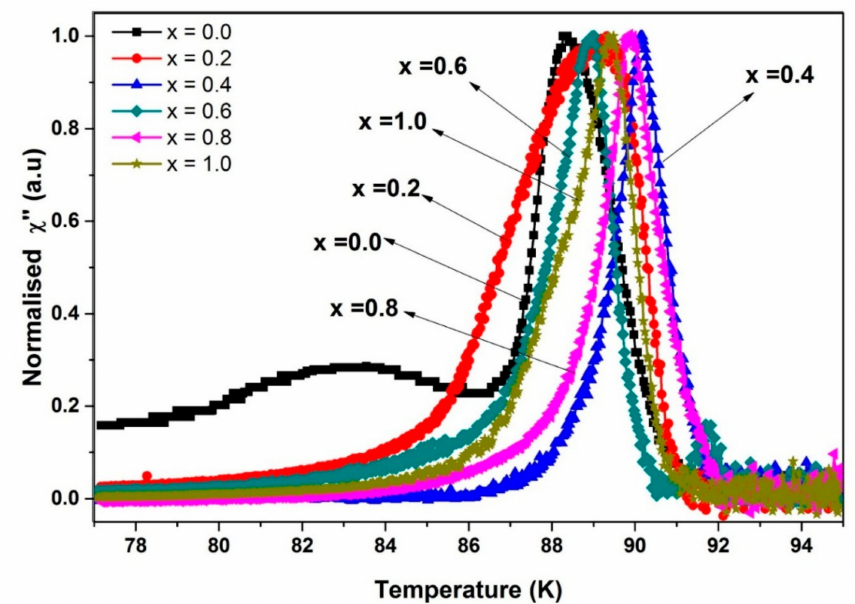
Figure 8. The imaginary part of the normalised susceptibility curve for Y-123 with x = 0.0, 0.2, 0.4, 0.6, 0.8, and 1.0 wt.% SnO 2 addition. Table 3. H ac , T c-onset , T cj , T p , and I 0 for Y-123 at x = 0.0, 0.02, 0.4, 0.06, 0.8, and 1.0 SnO 2 addition. SnO 2 Addition ( x =